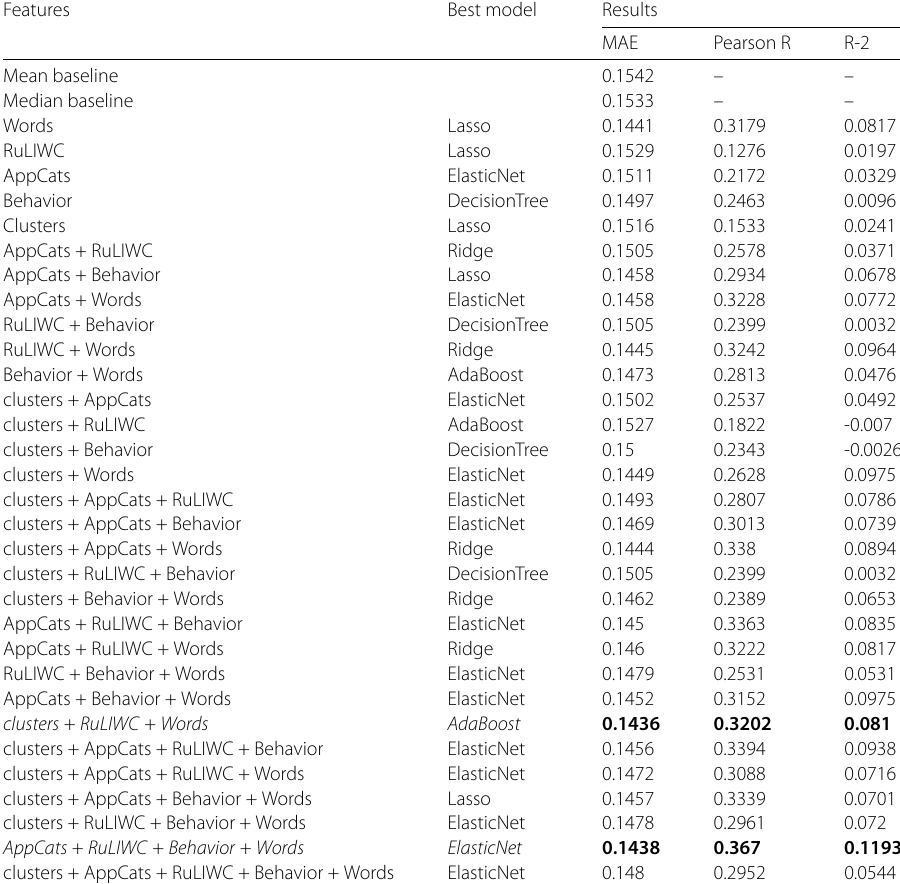
Table 20 WHO-5 regression results for all feature sets